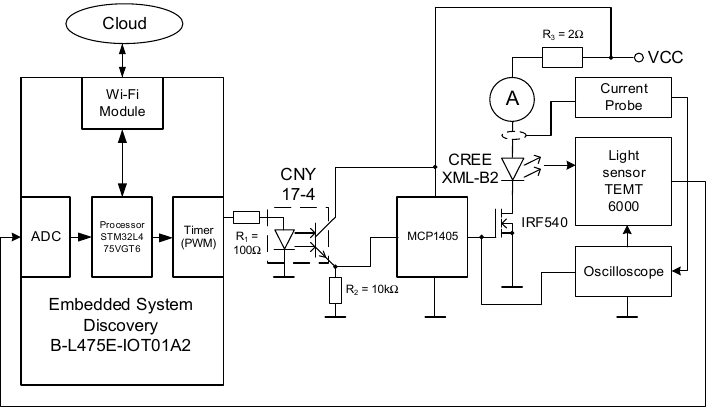
Figure 2. Block diagram of an embedded system for controlling the lighting of an office station.